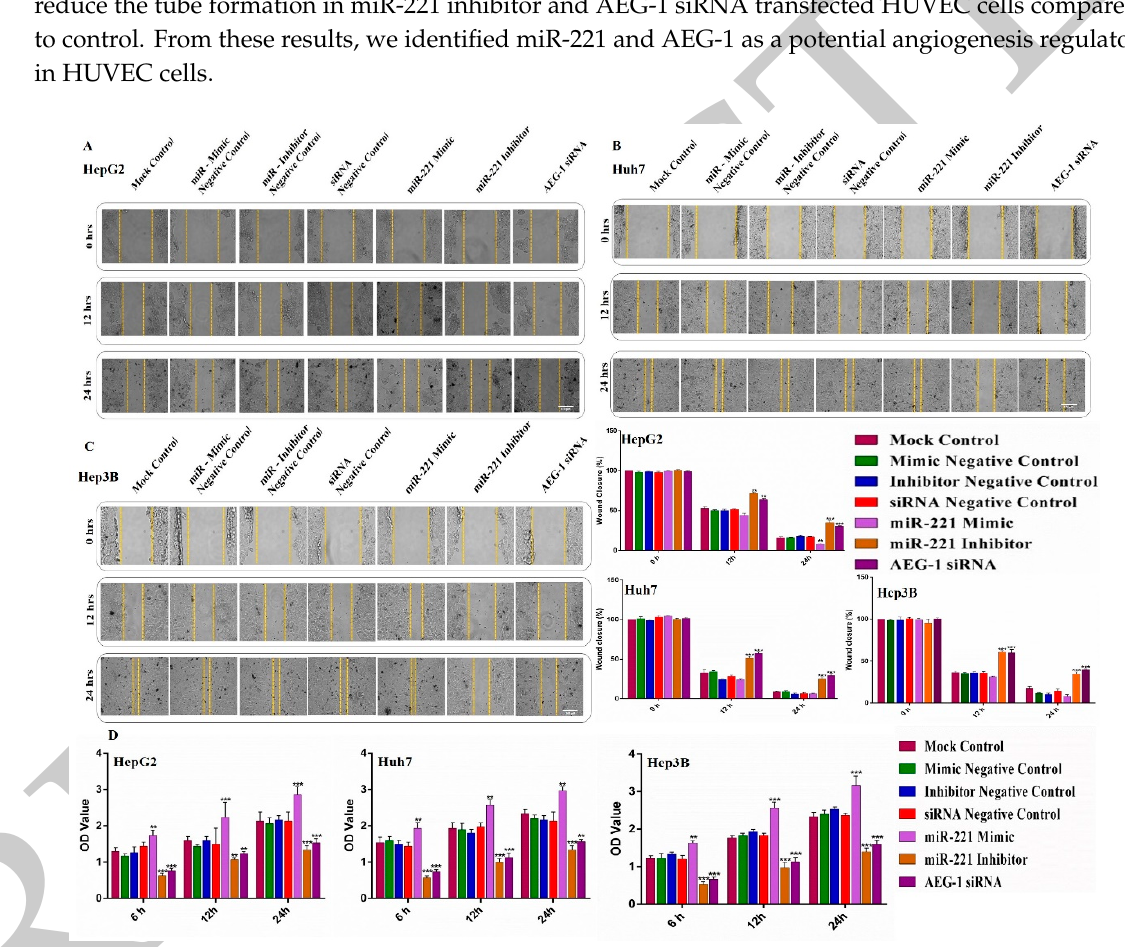
Figure 4. Knockdown of miR-221 and AEG-1 inhibits cell migration, proliferation in HCC cells in vitro. Effect of miR-221/AEG-1 on HCC cell migration and proliferation was analyzed by scratch assay and MTT assay in vitro. HepG2 ( A ), Huh7 ( B ) and Hep3B ( C ) cell lines were transfected with miR-221 mimic, miR-221 Inhibitor, AEG-1 siRNA, and their negative controls. Wound gap distance of cells was quantified in 0, 12, 24 h post-transfection by using Image J (scale bar, 100 µ m). Cell proliferation was measured by MTT assay in miR-221 mimic, miR-221 inhibitor, AEG-1 siRNA, and their negative control transfected HCC cells ( D ). Error bars are presented as mean ± s.d. and ** p < 0.01, *** p < 0.001 compared to the negative